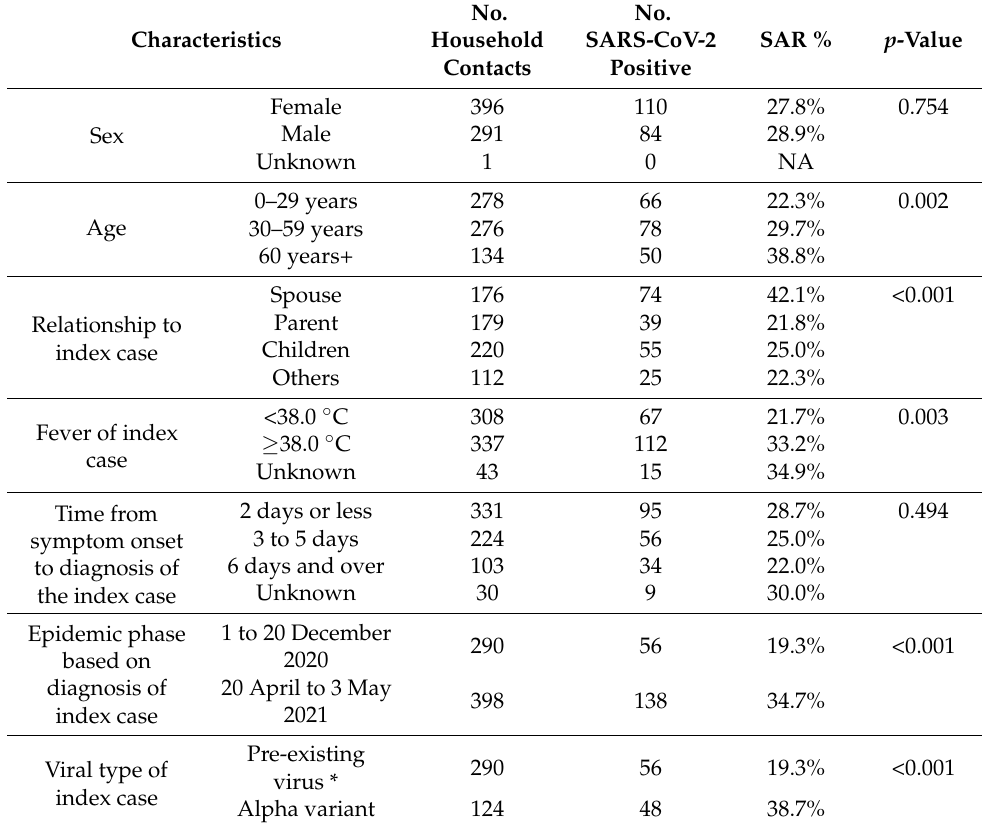
Table 1. Secondary attack rate (SAR) of SARS-CoV-2 for Japanese household contacts according to their